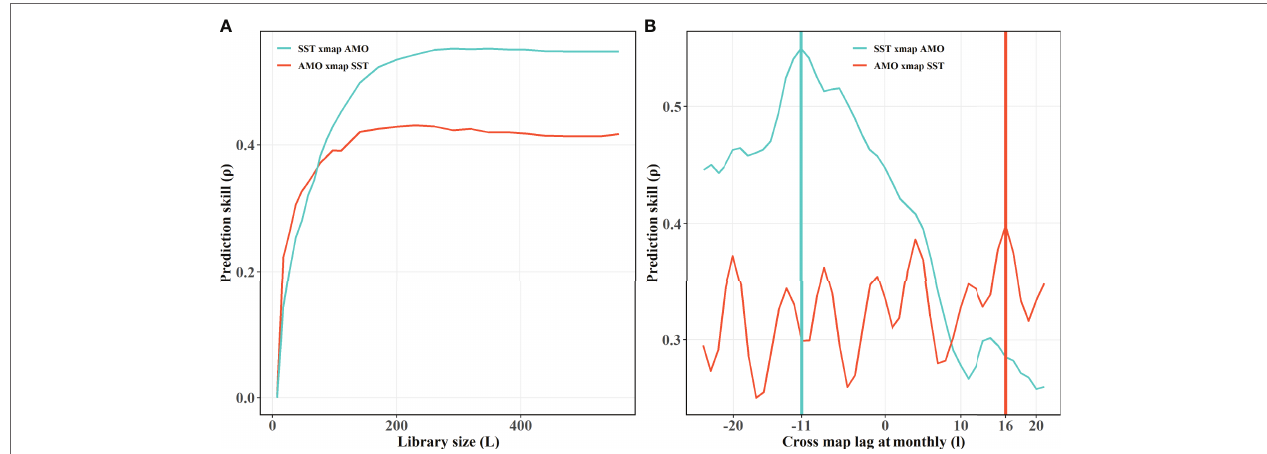
FIGURE 9 | Results of the CCM and ECCM applied to the nonlinear dynamics of SST and the AMO. (A) Results of the CCM without time lag, (B) Results of the ECCM at different lags (l = 1 month). The blue lake lines indicate that the AMO causes SST; the bright orange lines represent the opposite effective directions from SST to AMO. The vertical lines in panel b represent the optimal lag times by the best prediction skills at varying interaction directions, respectively